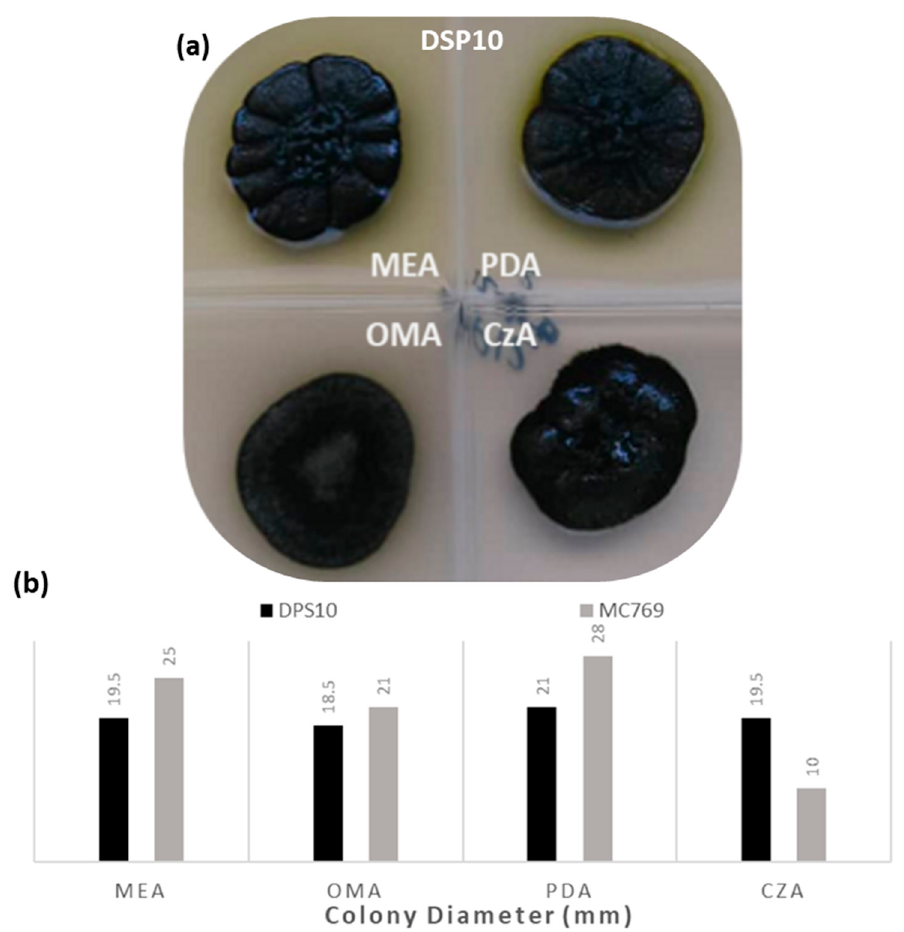
Figure 2. Colonies of Pseudotaeniolina globosa grown on different media (MEA, Oatmeal Agar (OMA), Potato Dextrose Agar (PDA), Czapek Dox Agar (CzA)). ( a ) Colonies of DPS10 isolate on the four media; ( b ) Colonies diameter are compared with MC769 isolate according to published data by De Leo et al. [16].